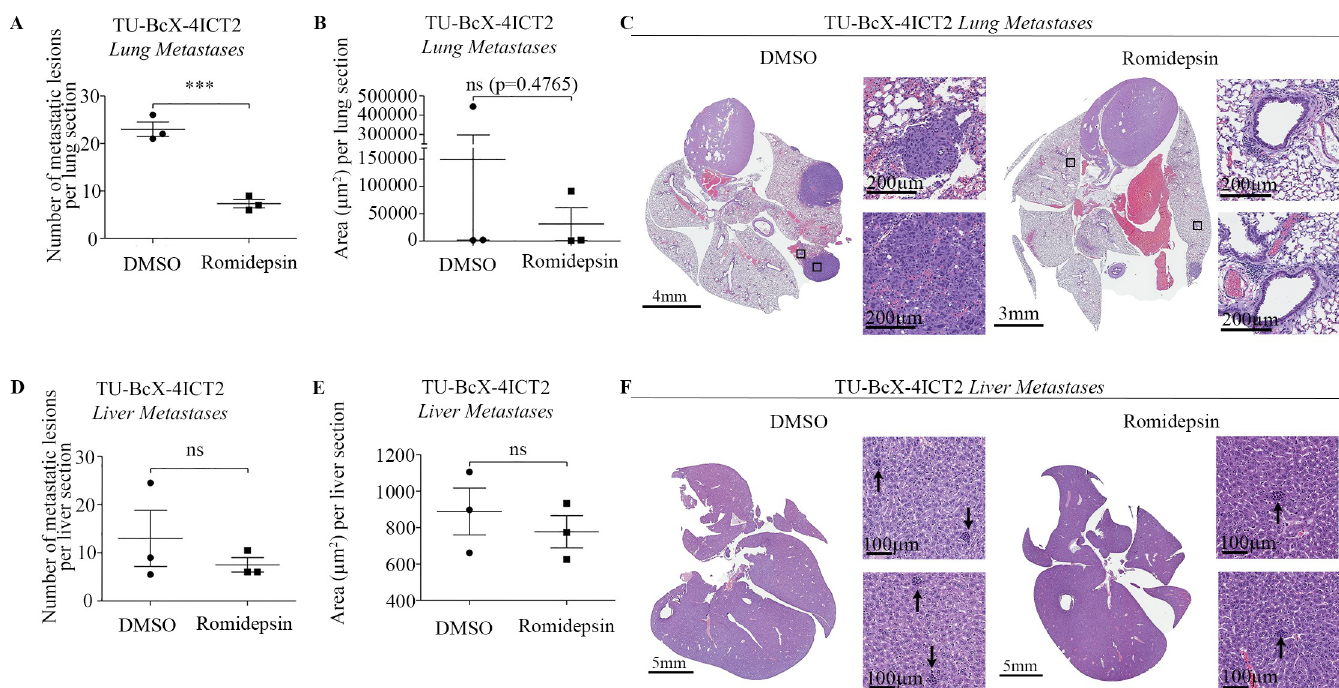
Fig 3. Romidepsin effect on metastasis in TU-BcX-4IC-implanted mice. Lungs and livers from mice implanted with TU-BcX-4IC and treated with romidepsin or DMSO vehicle were harvested, formalin-fixed, paraffin-embedded, and H&E-stained to visualize and quantify metastases. Romidepsin treatment (A) significantly decreased the number of metastatic lesions per lung section and (B) overall decreased the area of lung metastases compared to DMSO vehicle control. (C) Representative images of H&E-stained lungs in both treatment groups. The black box on the low magnification images indicates the regions shown in the higher magnification views. In liver sections, romidepsin (D) dramatically reduced the number of metastatic lesions per liver section and (E) overall decreased the area of liver metastases compared to DMSO, but these findings were not statistically significant. (F) Representative images of H&E-stained livers with arrows indicating metastatic foci in both treatment groups. Error bars represent standard error of mean (S.E.M.). ��� p < 0.0001; ns = not